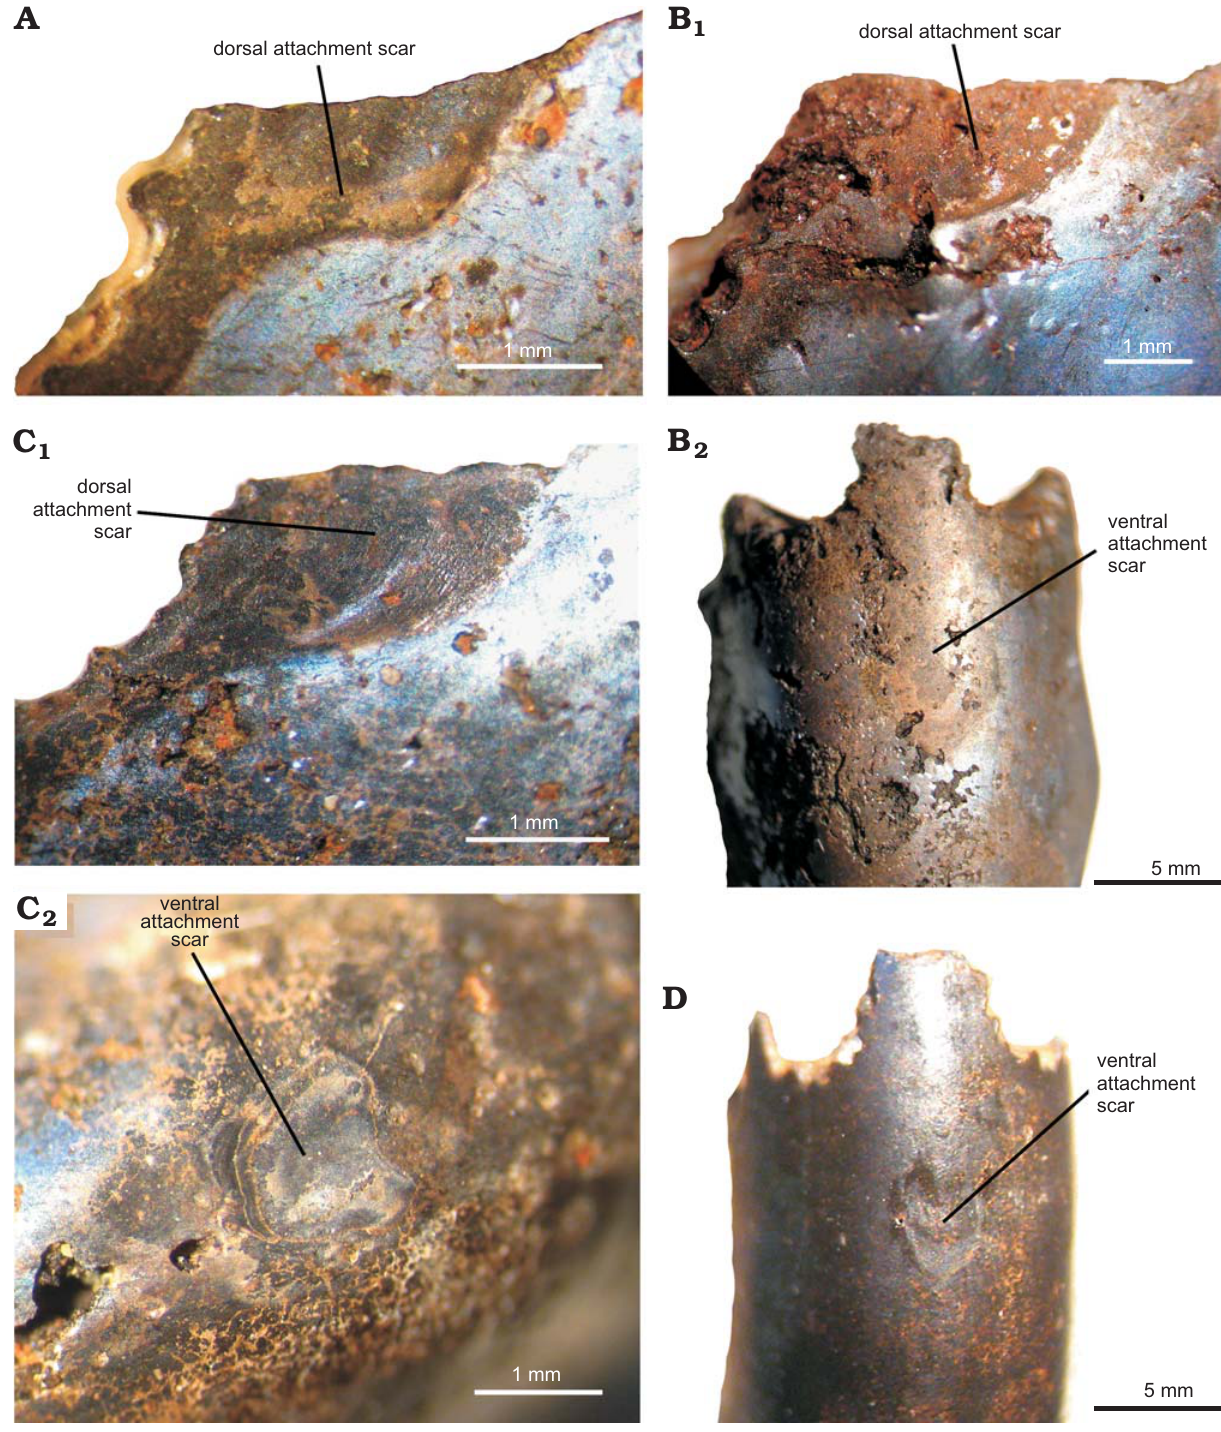
Fig. 12. Dorsal and ventral attachment scars on Kachpurites fulgens (Trautschold, 1861) shells from Late Volgian ( Kachpurites fulgens Zone), Moscow region, Kuntsevo locality (A, C) and Mnevniki locality (B, E). A . MSU 113/37, dorsal scar, apical parts of scars are merged with an annular elevation (black line near the last septum). B . MSU 113/40, dorsal (B scar (C ). D . MSU 113/41, ventral attachment 2